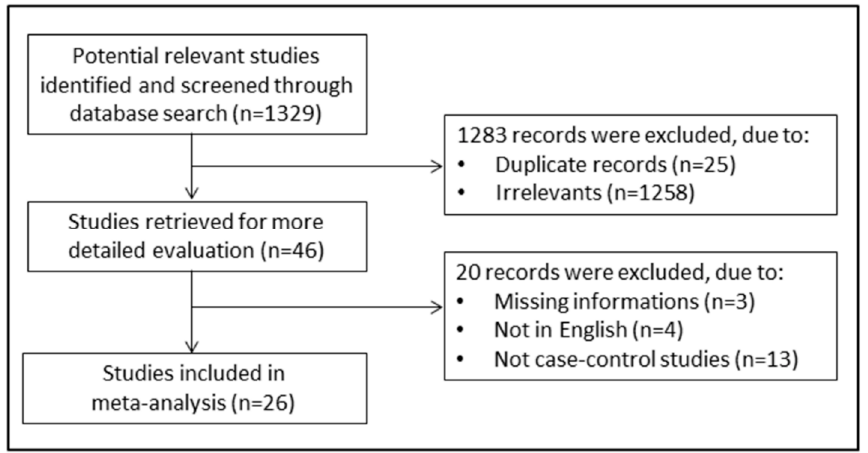
Figure 1. Flow chart of study selection.